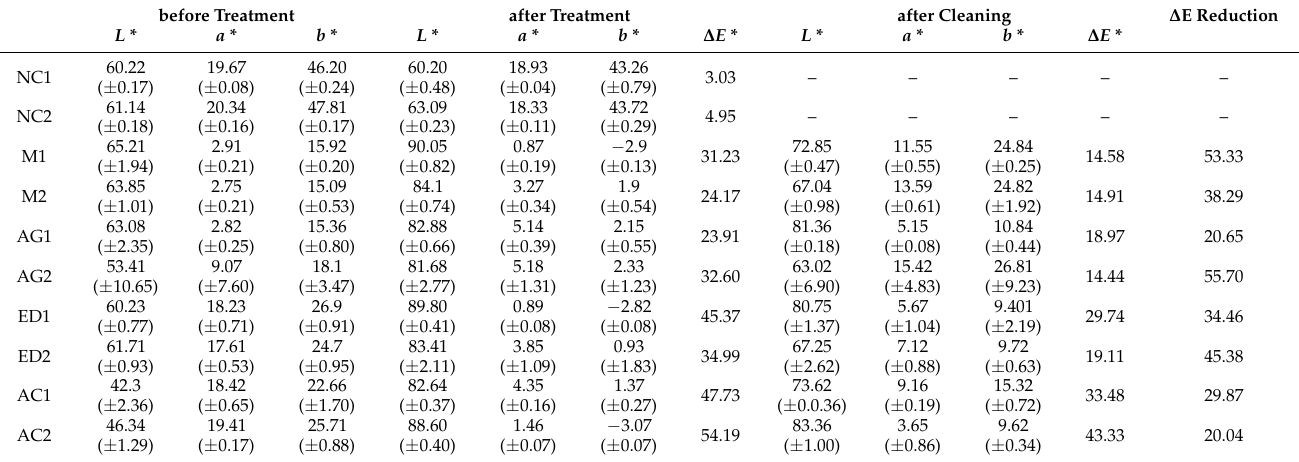
Table 4. Chromatic alterations for treated and cleaned